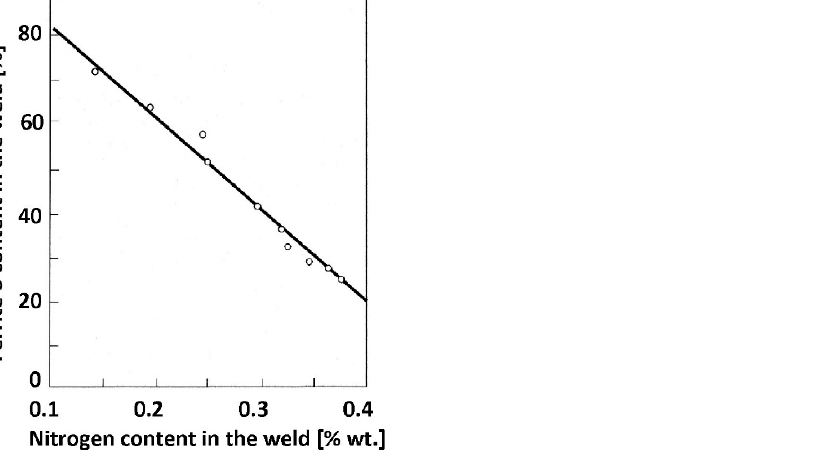
Figure 13. Influence of nitrogen content in a weld made with the TIG method on the volume fraction of δ -ferrite in the steel microstructure (according to [52]).